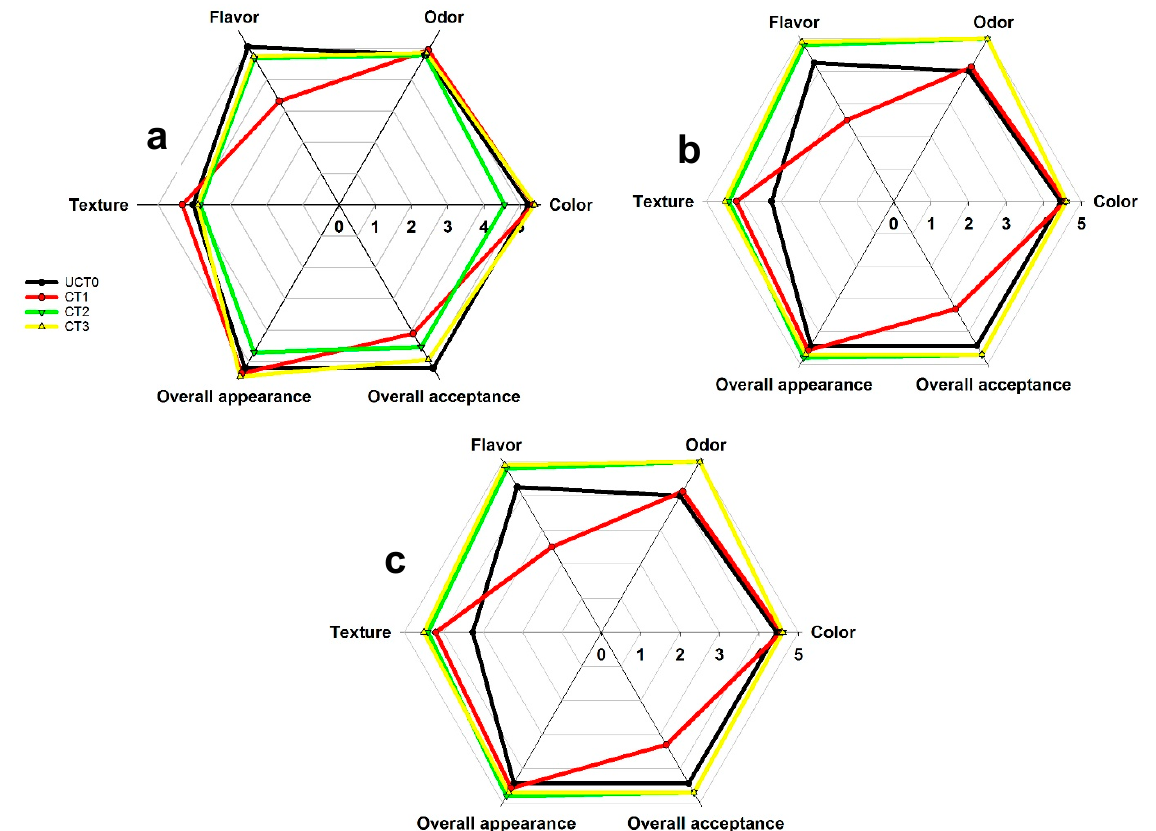
Figure 8. Sensory analyses of Golden Delicious apple slices coated (with CT1, CT2, and CT3), and uncoated at 0 ( a ), 5 ( b ), and 10 ( c ) days of storage at 4 °C in dark conditions and 85% relative humidity (RH). Values indicate the means for the following attributes: color, odor, flavor, texture, global appearance, and global acceptance. Abbreviations: UCT0, uncoated apple slices used as control; CT1, apple slices coated with chitosan-glycerol-cinnamon oil; CT2, apple slices coated with guar gum-glycerol-cinnamon oil; CT3, apple slices coated with composite guar gum-starch-glycerol-cinnamon oil.